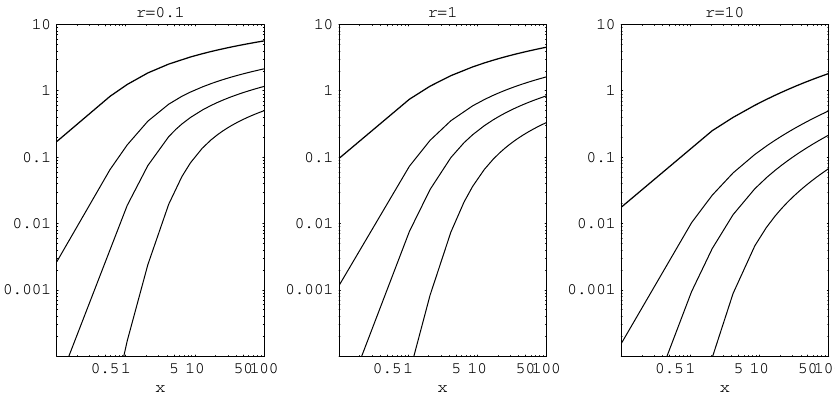
(cid:2) x; r (cid:4) versus x . n